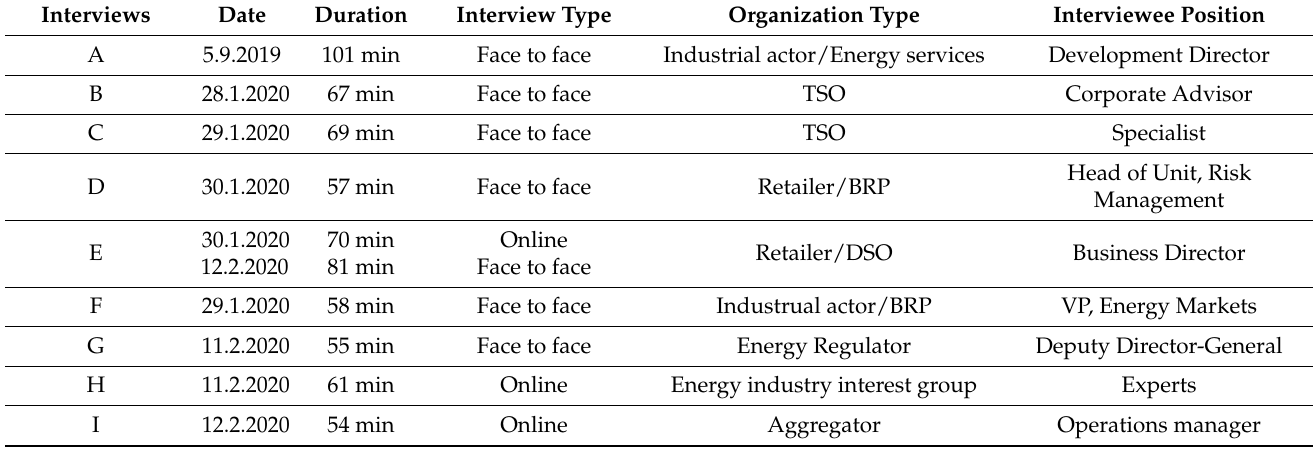
Table 1. Interviews from the Finnish energy ecosystem.